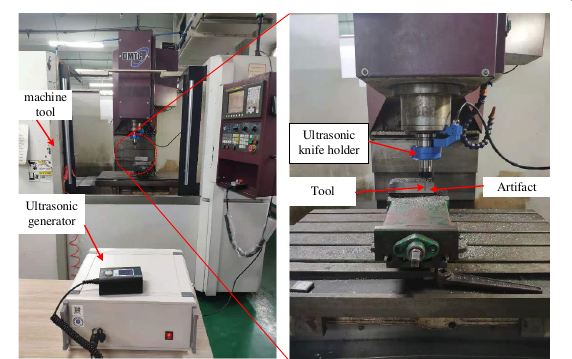
Figure 9 Test Platform in this research